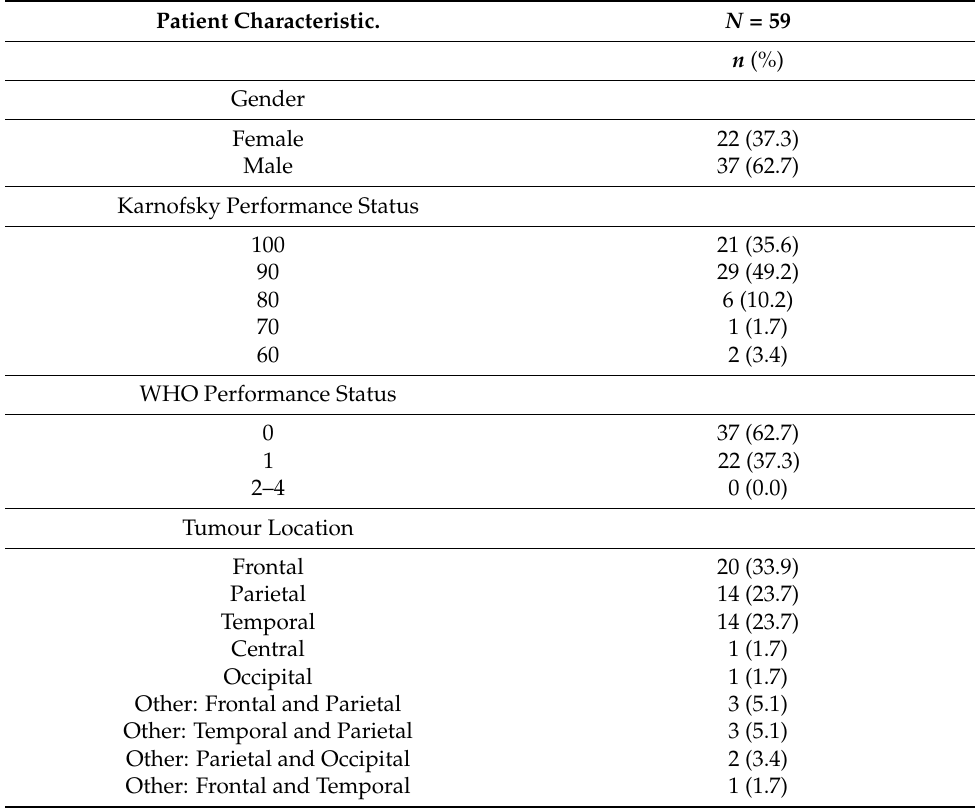
Figure 1. Consort diagram. Table 1. Patient characteristics—eligible